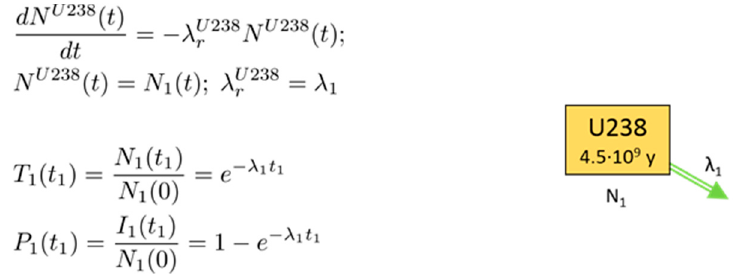
Figure 3. First transmutation trajectory in the 238 U chain.